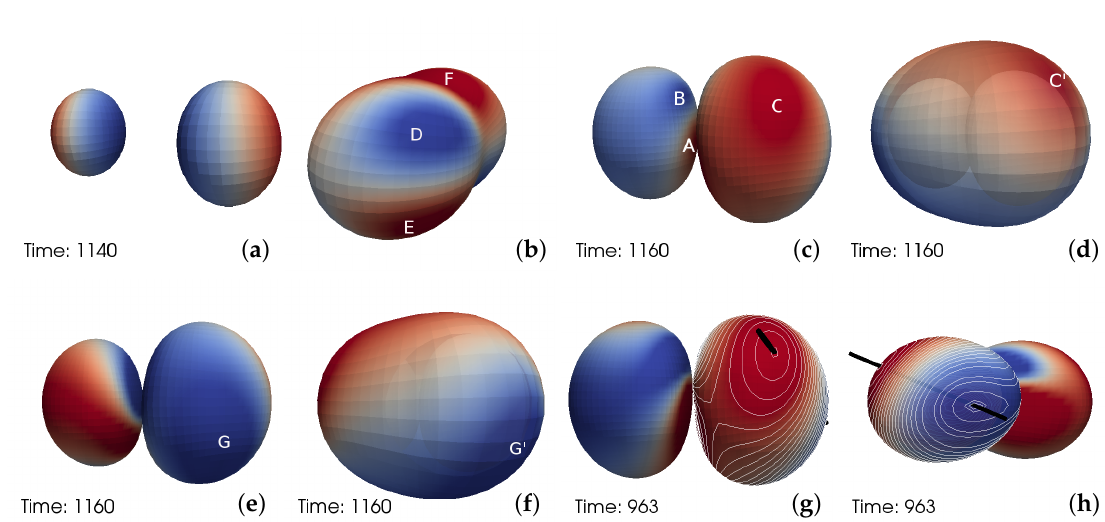
Figure 5. ( a ): The inspiral phase of the SK simulation, where the dipolar B NN patterns on each individual horizon can be used to identify the spin direction. The red color corresponds to + ve B NN , and the spin of each black hole points from the blue patch towards the red patch. ( b ): The post-merger B NN for the AA simulation. In addition to the dipolar patch F due to the spin of the remnant black hole, the individual remnant spin patches D and E are also clearly visible, which shows that the spins remain in the anti-aligned orientation as expected. These spin patches retain this orientation throughout the merger phase. ( c ): Immediately before the merger in the SK simulation. Note that there are two patches on the inside identified as A and B , which do not have counterparts in panel ( a ) for the inspiral phase. ( d ): Same as ( c ) but includes the common apparent horizon as a semi-transparent surface. The patch C (cid:48) on the common horizon corresponds to the patch C on the individual horizons. ( e , f ): Similar to ( c , d ), but for the SK- simulation instead of the SK simulation. ( g , h ): Similar to ( c ), but for the SK ⊥ simulation. ( g ) is the front view showing the + ve B NN spin patch, while ( h ) is the side view showing the − ve B NN spin patch. The white curves are the contours of B NN , and we have drawn a thick black line connecting the centers of the two spin patches. The orientation of this line is used as an approximate measure of the spin